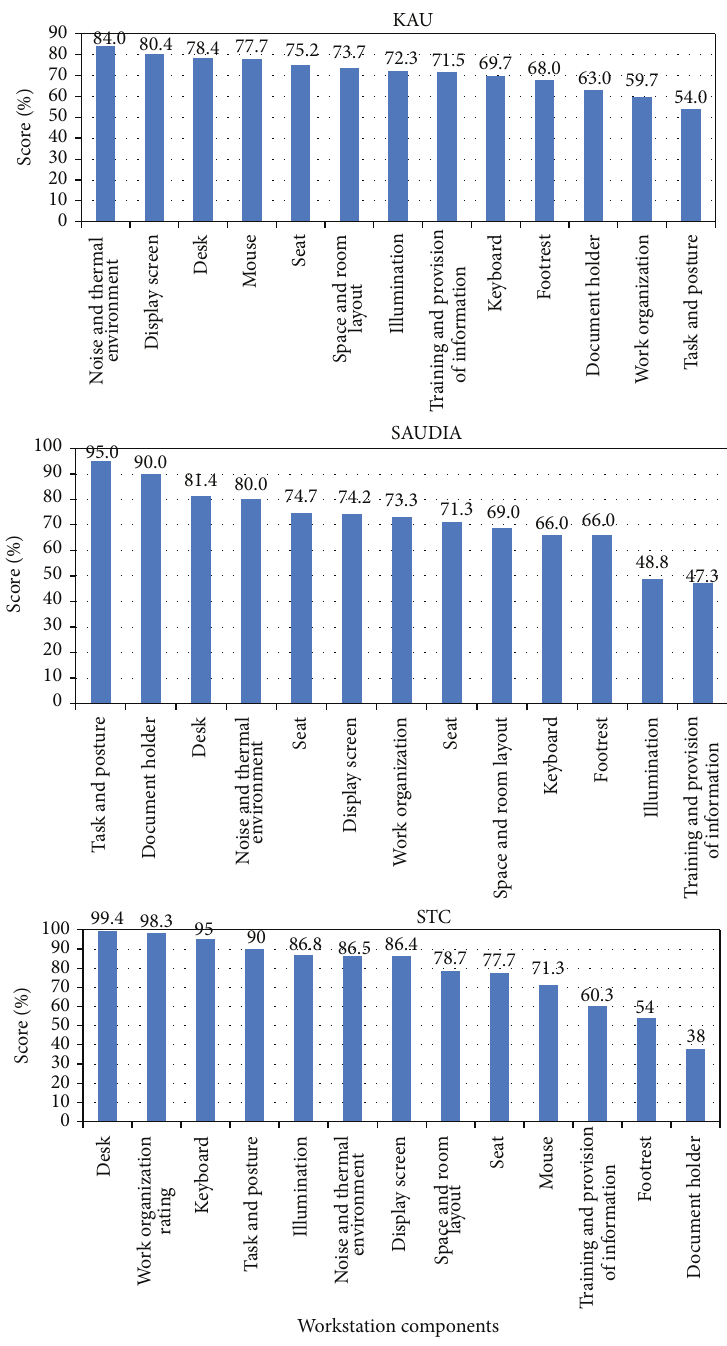
Figure 1: Average ergonomics scores of the examined workstation